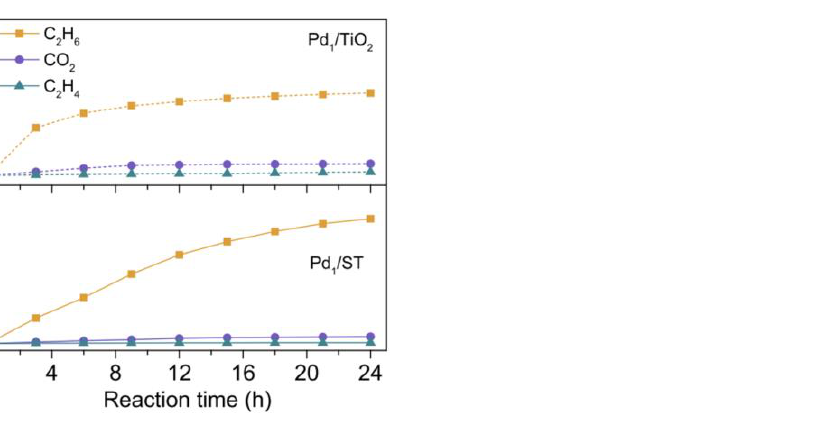
Figure 6. The comparison of production rate between Pd 1 /TiO 2 and Pd 1 /ST [54]. Copyright 2022, Springer Nature.